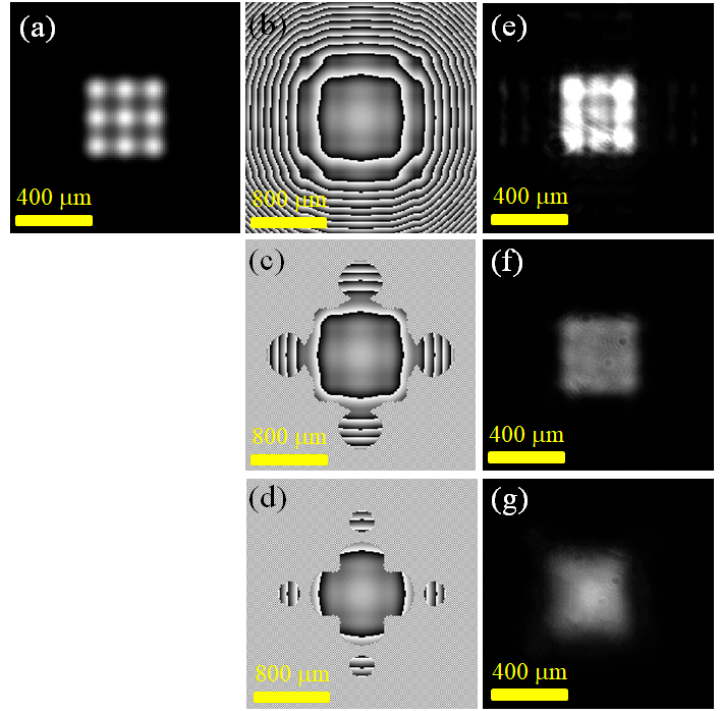
Figure 6. Experiments of generating a rectangular light field using amplitude masks with different truncated ranges: ( a ) the calculated 9-point light intensity; ( b ) the SLM projected phase diagram in which no amplitude mask is used; ( c ) the SLM projected phase diagram in which the mask cuts off a smaller range of light fields; ( d ) the SLM projected phase diagram in which the mask cuts off a larger range of light fields; ( e ) the resulting light field distribution in which no amplitude mask is used; ( f ) the resulting light field distribution in which the mask cuts o ff a smaller range of light fields; ( g ) the resulting light field distribution in which the mask cuts o ff a larger range of light